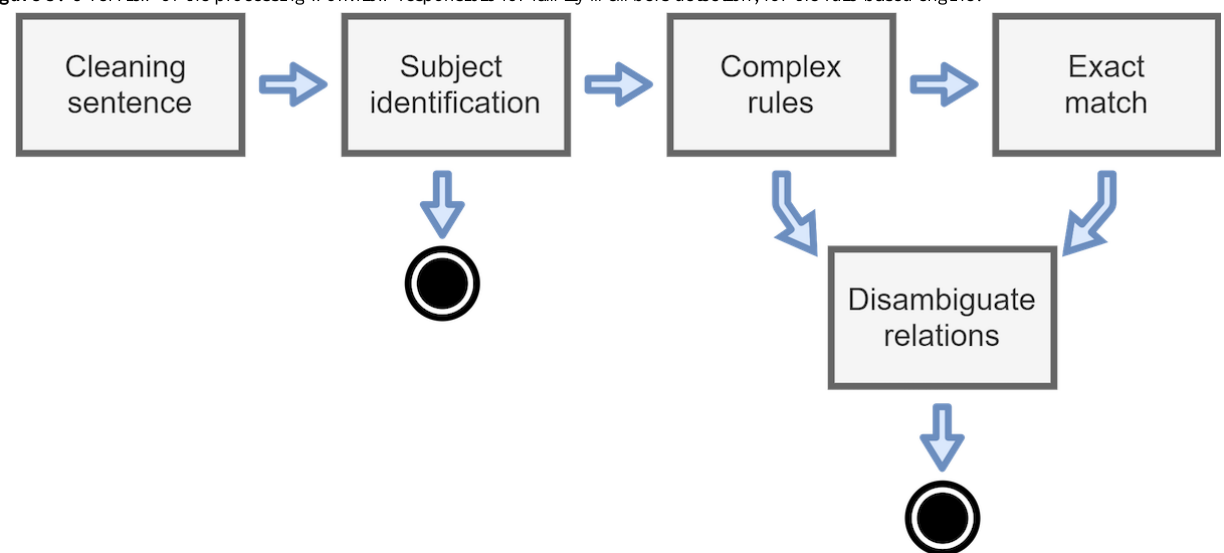
Figure 3. Overview of the processing workflow responsible for family members detection, for the rule-based